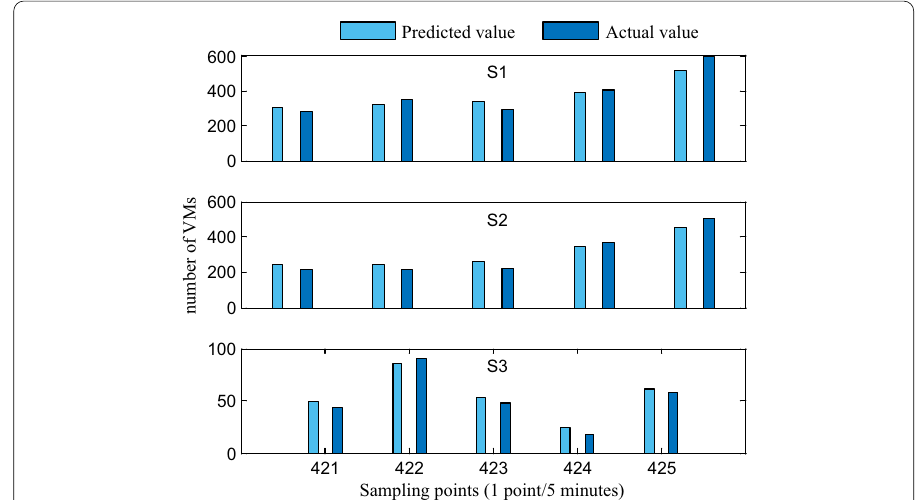
Fig. 8 Number of the predicted VMs for the S1, S2 and S3 sequences. The first, second and third subgraphs depict the comparison between the actual values and the predicted 5-point values obtained by our proposed method APMRT for the preprocessed S1, S2 and S3 sequences, respectively